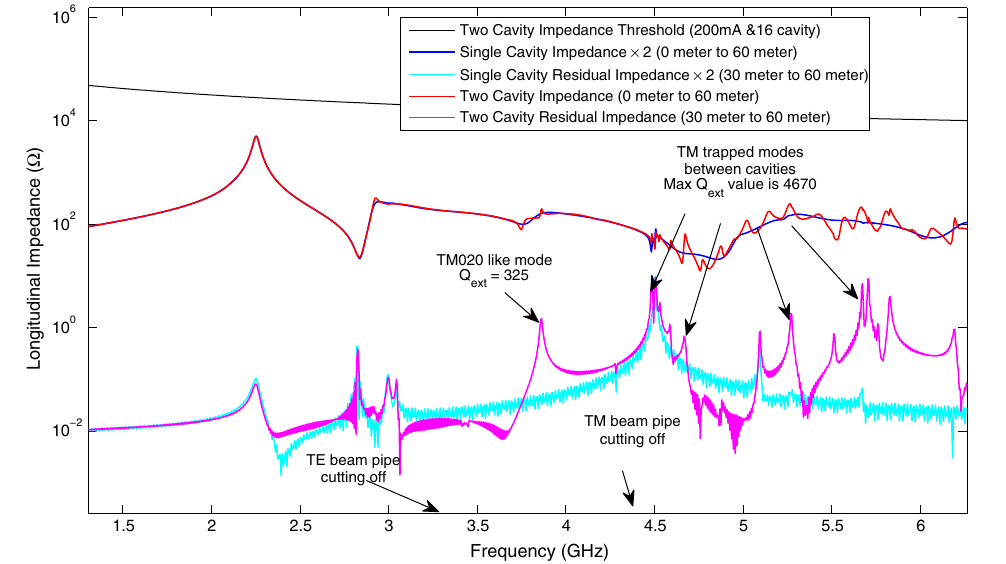
FIG. 16. Longitudinal wake impedance Z 0 ∥ comparison between the two-cavity model and the single-cavity model. The impedances are all based on the L ¼ 60 m wake